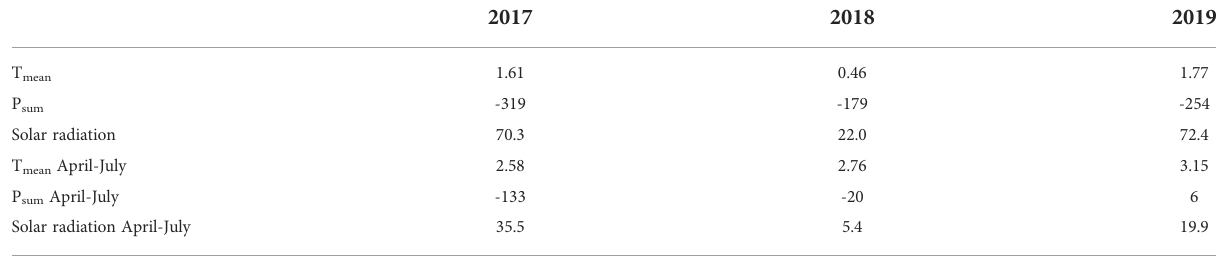
TABLE 2 Differences of average temperature (T mean , °C), sum of precipitation (Ps um , mm) and solar radiation (Wh m -2 ) between Balti and Freising within the individual years and within individual growing seasons from April to